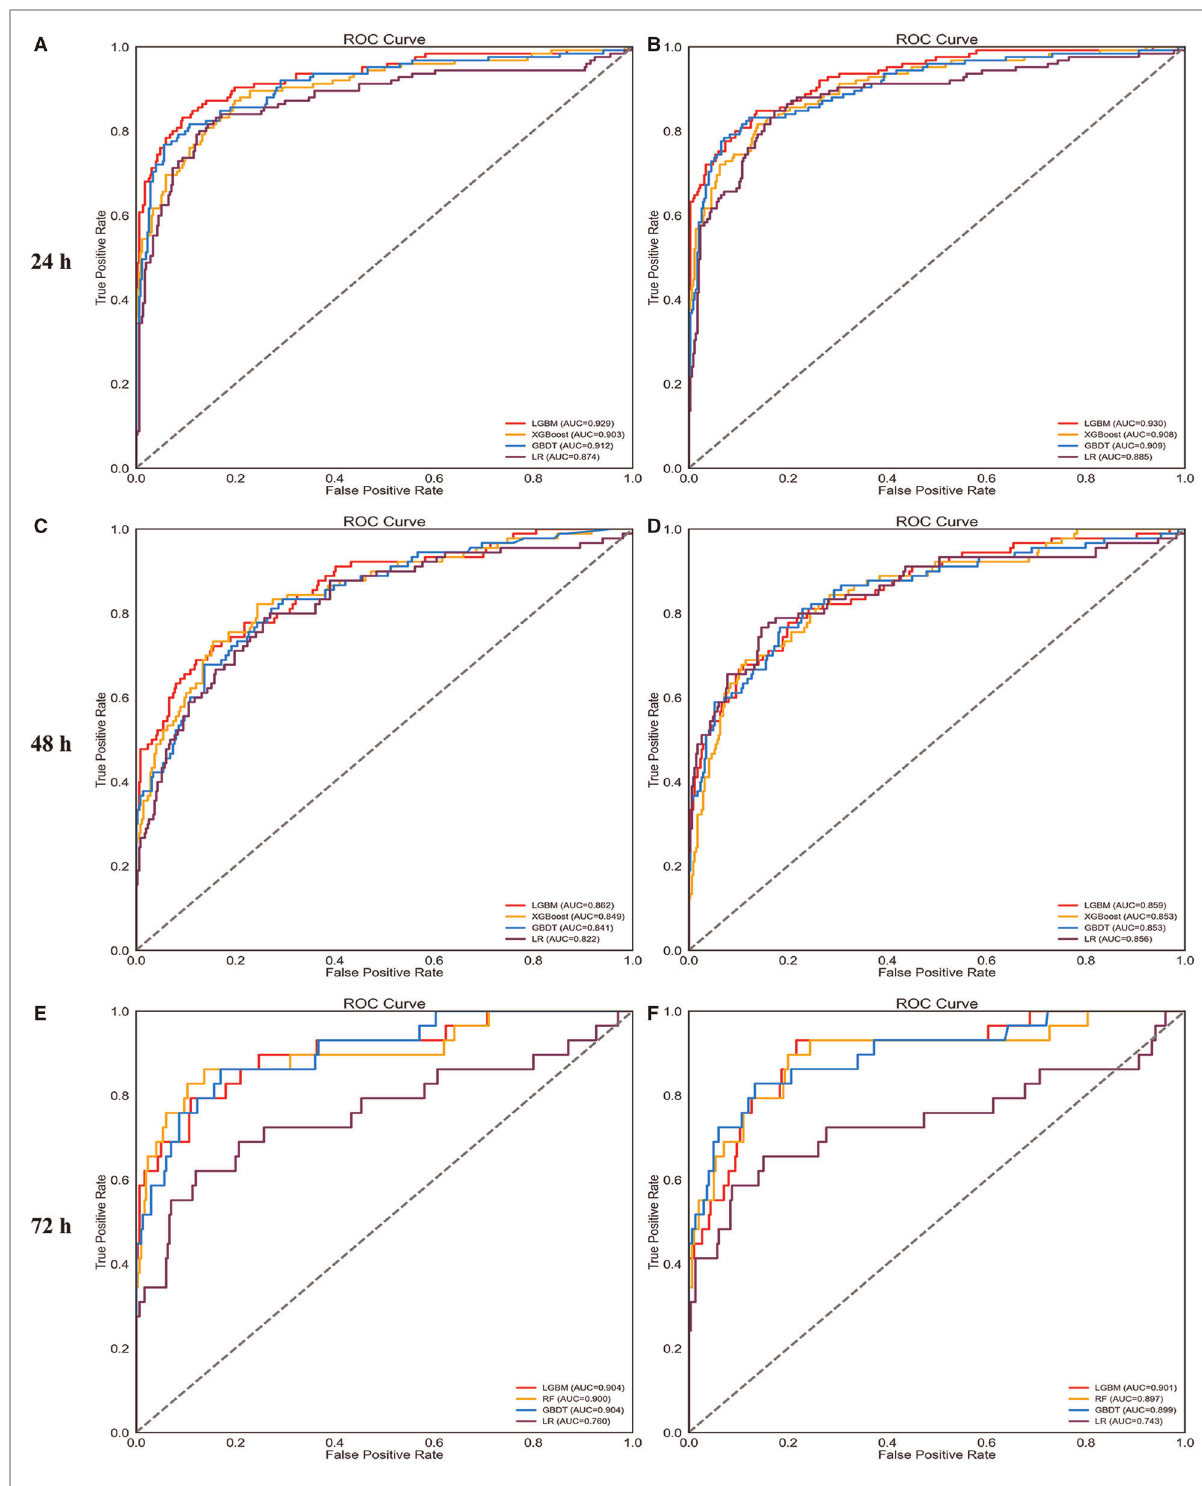
FIGURE 3 ROC curves of four prediction models using all features ( A,C,E ) and important features ( B,D,F